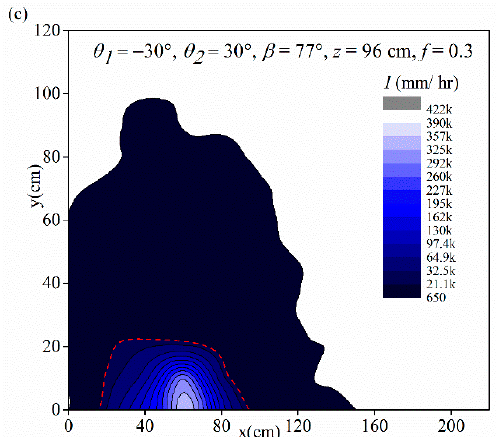
Figure 6. Rainfall intensity distribution at different section heights on the x - o - y measuring platform. ( a ) θ 1 = − 30 ◦ , θ 2 = 30 ◦ , β = 77 ◦ , z = 56 cm, and f = 0.3; ( b ) θ 1 = − 30 ◦ , θ 2 = 30 ◦ , β = 77 ◦ , z = 76 cm, and f = 0.3; ( c ) θ 1 = − 30 ◦ , θ 2 = 30 ◦ , β = 77 ◦ , z = 96 cm, and f = 0.3.